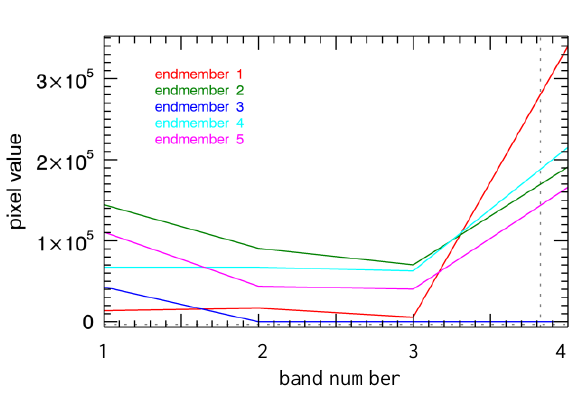
Figure 4 Endmember spectra for endmember 1 to 5.